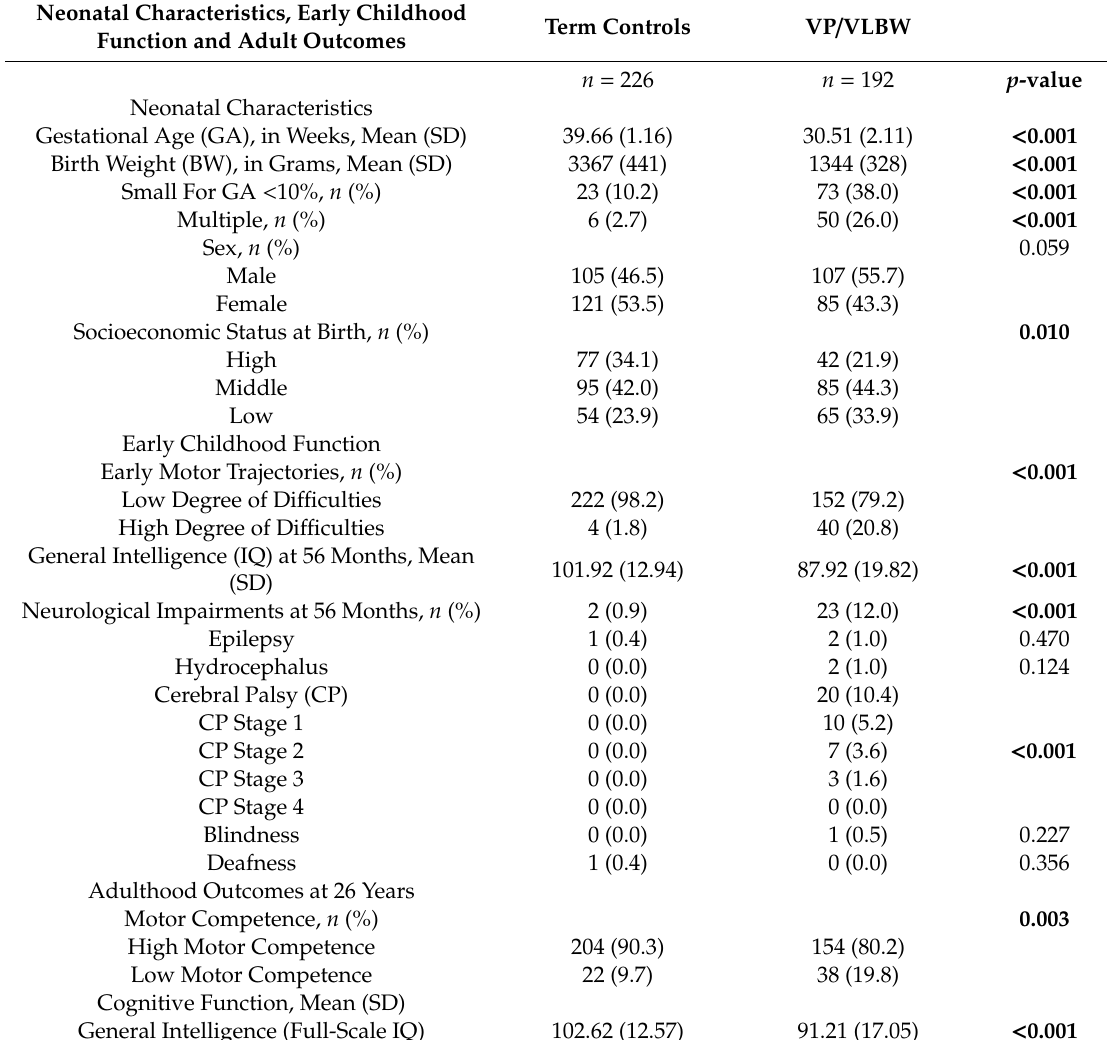
Table 1. Comparison of preterm and term control adults on neonatal characteristics, early childhood function, and motor competence and cognitive function in adulthood ( n =